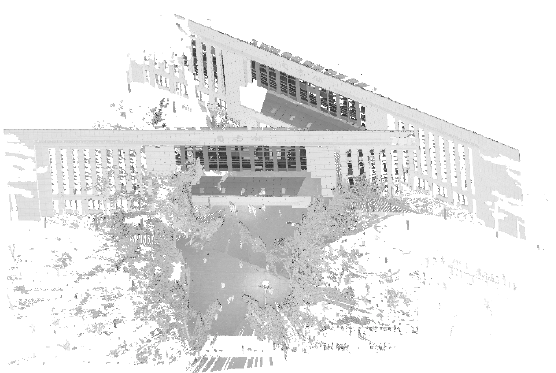
Figure 19. The target point cloud and the point cloud to be registered; the front is the point cloud to be registered, and the back is the target point cloud.